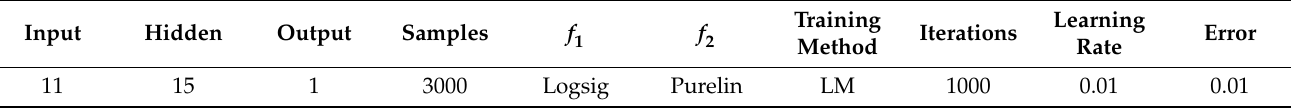
Table 5. Parameter settings in BP